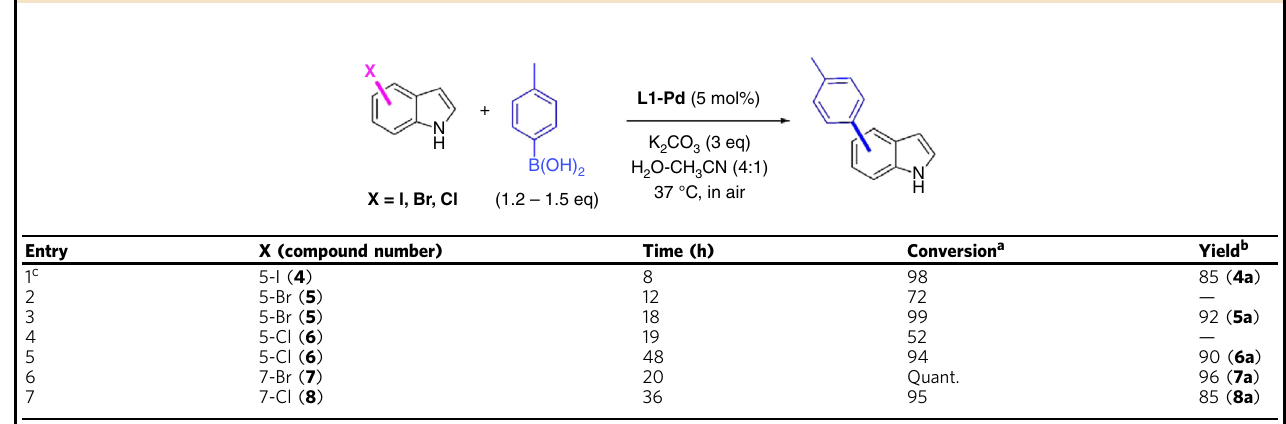
Table 1 Mild cross-coupling of halo-indoles